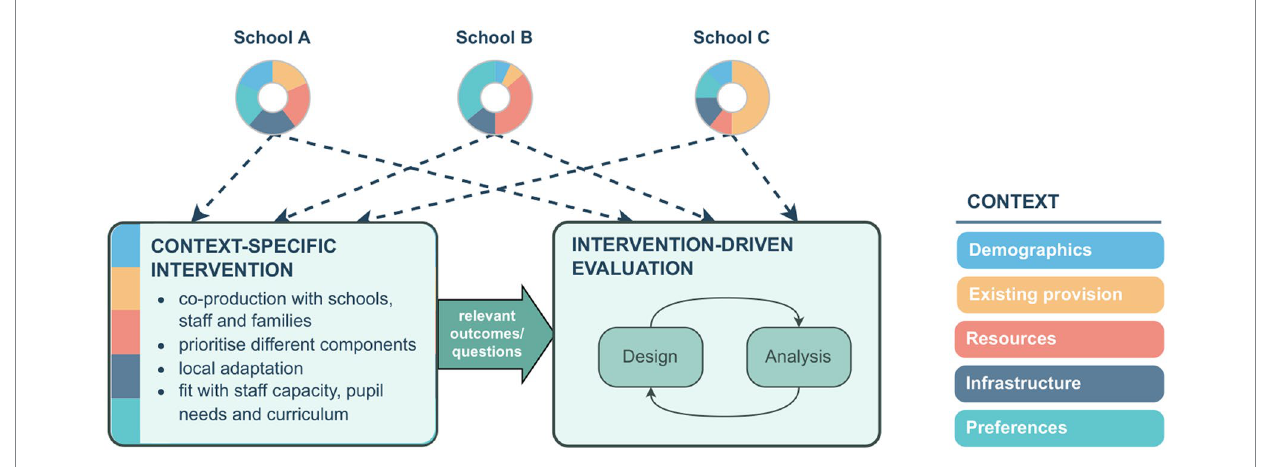
FIGURE 2 School-specific context feeds into the intervention design, and the intervention informs both the design and